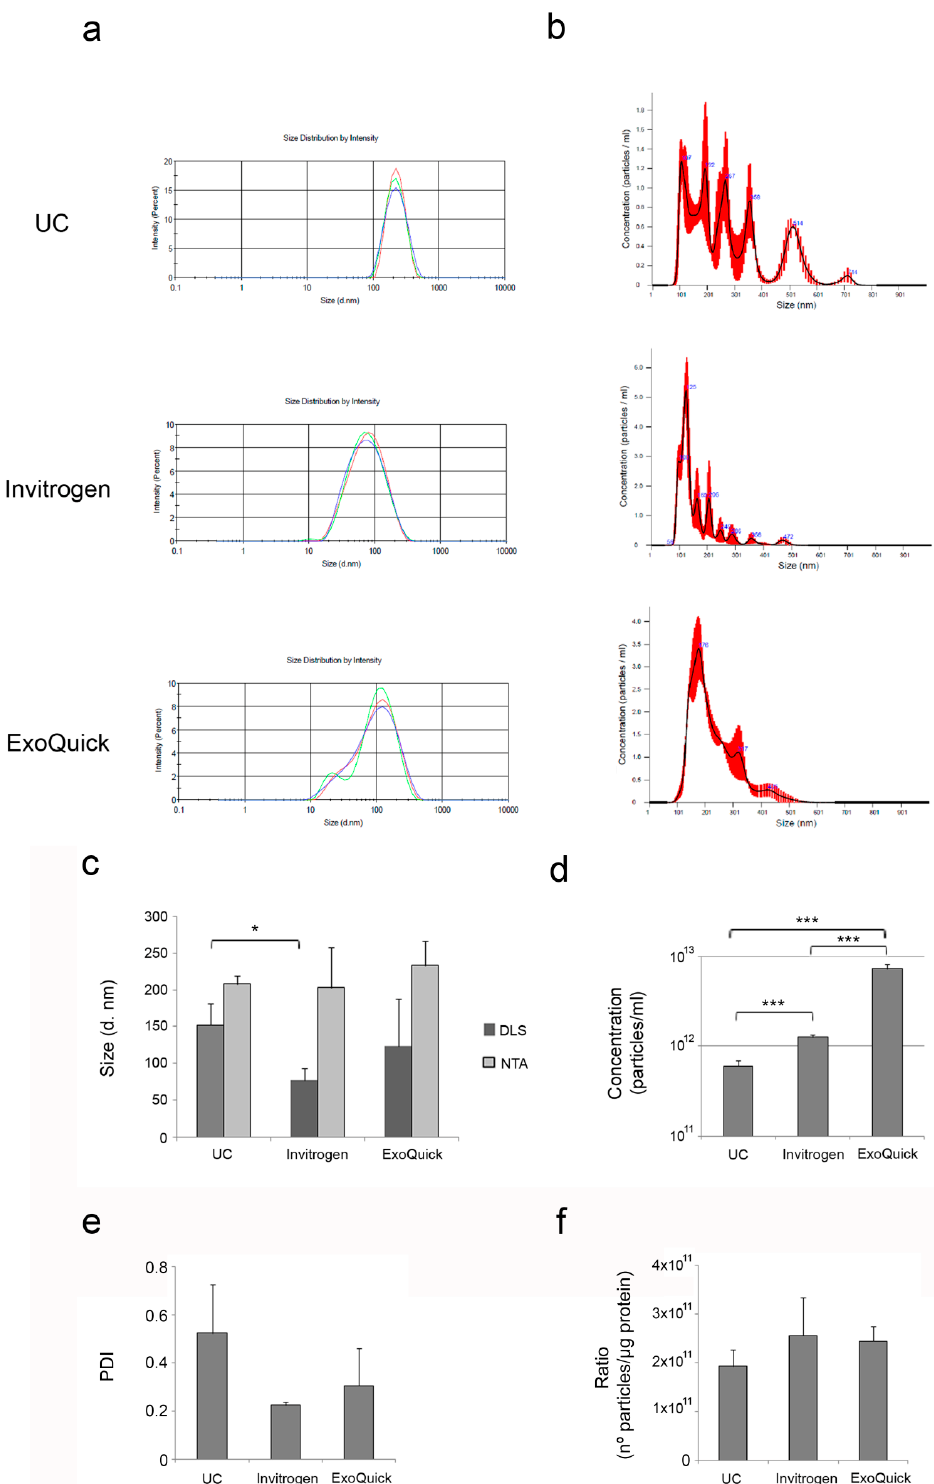
Figure 3. Characterization of plasma-derived EV. Hydrodynamic size distribution profiles of isolated EV measured by ( a ) DLS and ( b ) NTA. ( c ) Mean values + SD of the diameter sizes measured by DLS and NTA (n = 3). ( d ) Particle concentration of the EV fractions was measured by NTA. The graph shows the mean + SD of three independent experiments. ( e ) Mean values + SD of the PDI measured by DLS (n = 3). ( f ) Normalization of EV concentration determined by NTA per protein concentration measured by BCA. The graph shows the mean + SD of three independent experiments. * p < 0.05; ** p < 0.01; *** p <